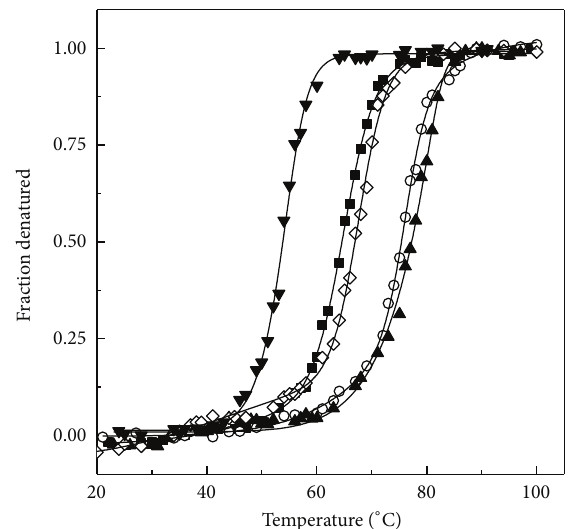
Figure 5: Far-UV CD spectra of the native (thick curve) and the thermal-denaturedGAsintheabsence(thincurve)andthepresence of 2.6M GLC (dashed curve), 1.3M TRE (dotted curve), 8M GLY (dashed with one dot curve), and 8M EG (dashed with two dots curve). The spectra of the thermal-denatured GA were recorded after equilibrating the sample at 71 ∘ C for 6min, using a protein concentration of 1.4 𝜇